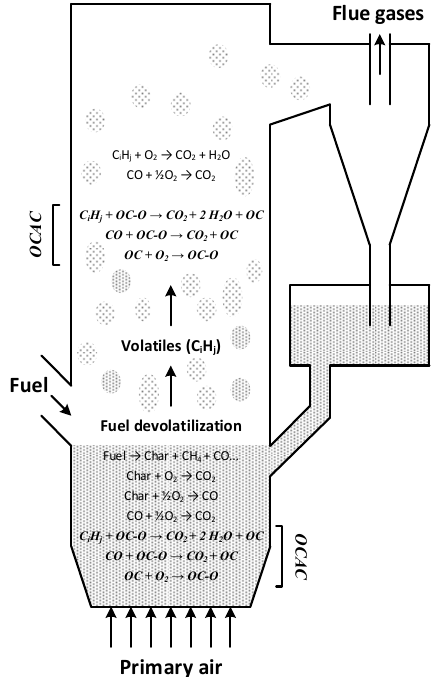
Figure 1. Schematic illustration of Oxygen Carrier Aided Combustion (OCAC) in Circulating Fluidized Bed (CFB) boiler. Simplified bulk reactions in dense bed and freeboard have been included, with new significant reaction pathways in italic. OC-O = oxidized oxygen carrier, OC = reduced oxygen carrier.